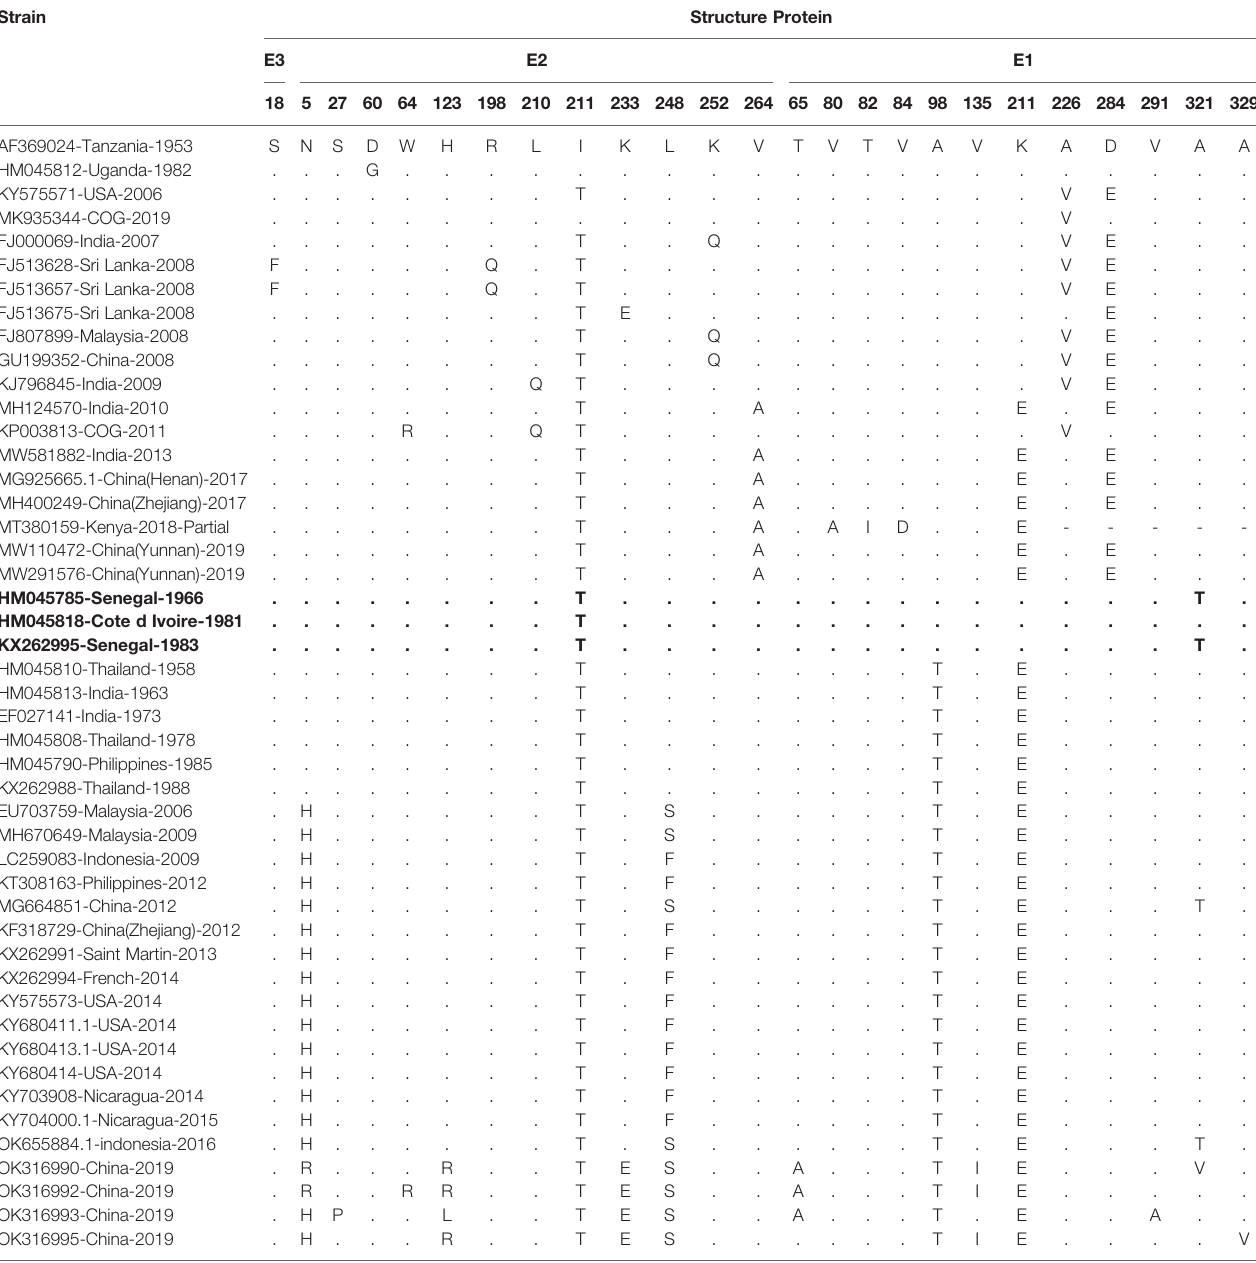
TABLE 2 | Amino acid mutations in the structural polyprotein of CHIKV. Strain Structure